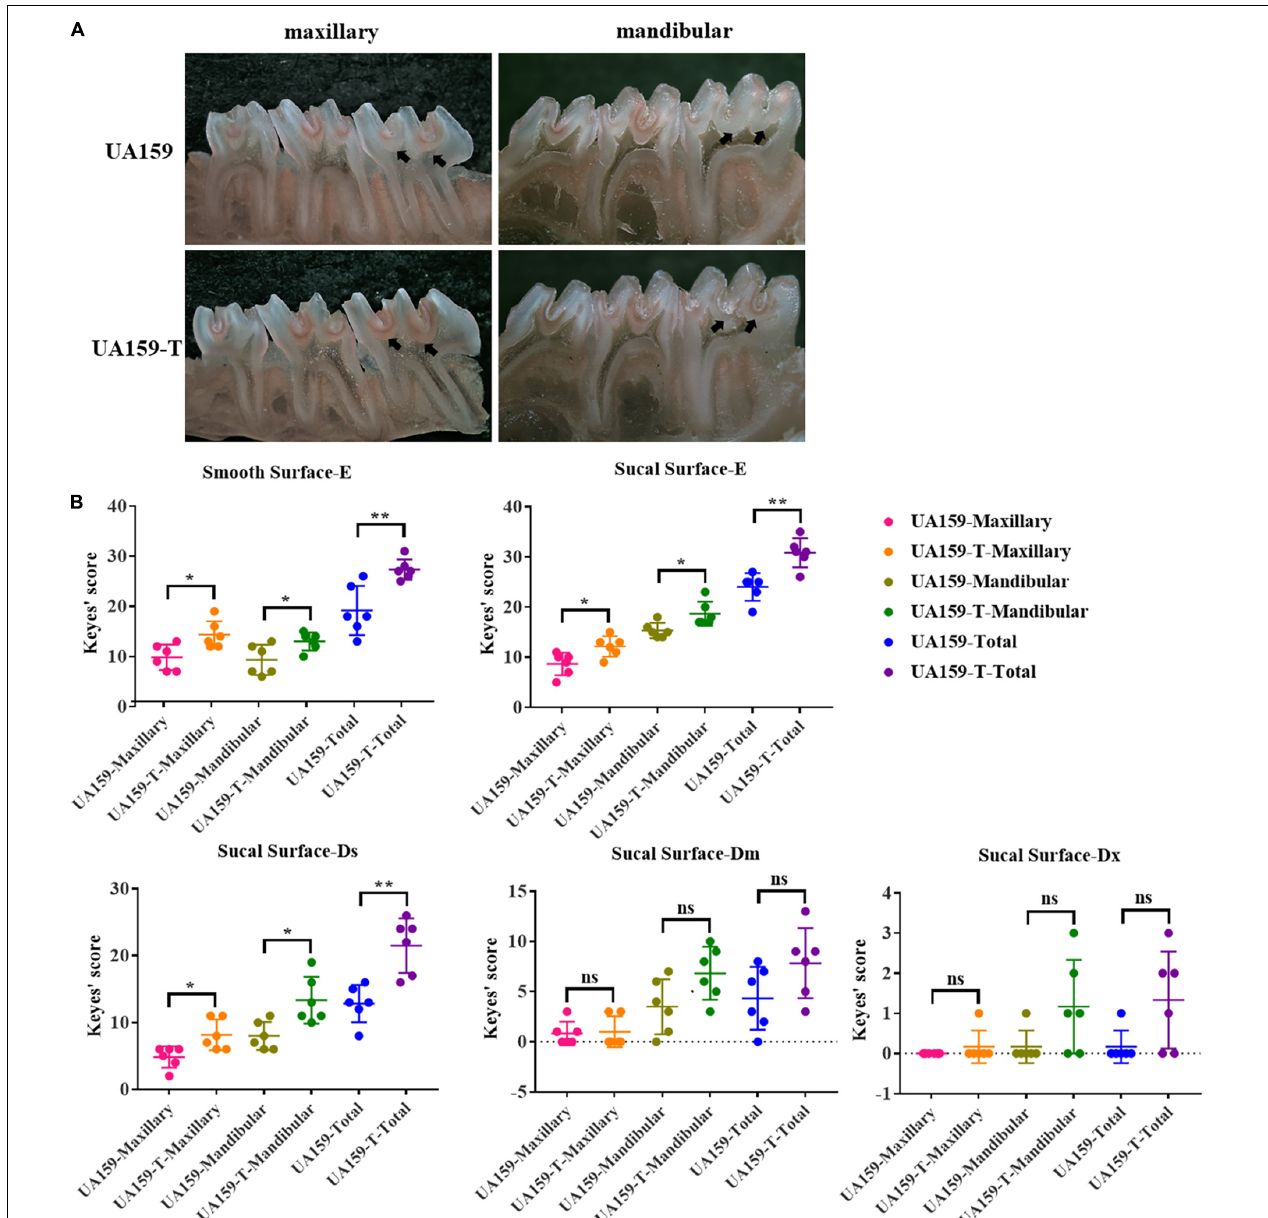
FIGURE 5 | Dental caries conditions and Keyes’ scores of rat caries models. (A) Stereomicroscopy images of dental caries on maxillary and mandibular bones of rats infected with UA159 and UA159-T. Black arrows point out different severity in the same site of the two groups. UA159-T strains led to severer dental caries than UA159. (B) Keyes’ scores of smooth surfaces and sulcal surfaces of two group (UA159 and UA159-T) and N = 6 per group: UA159-T strains achieved higher Keyes’ scores and led to severer dental caries than UA159. The significance level ( α ) was set at 0.05 (independent two-sample t -test, two-tailed test, IBM SPSS Statistics 24). * indicates P < 0.05. ** indicates P < 0.01. ns indicates no significant